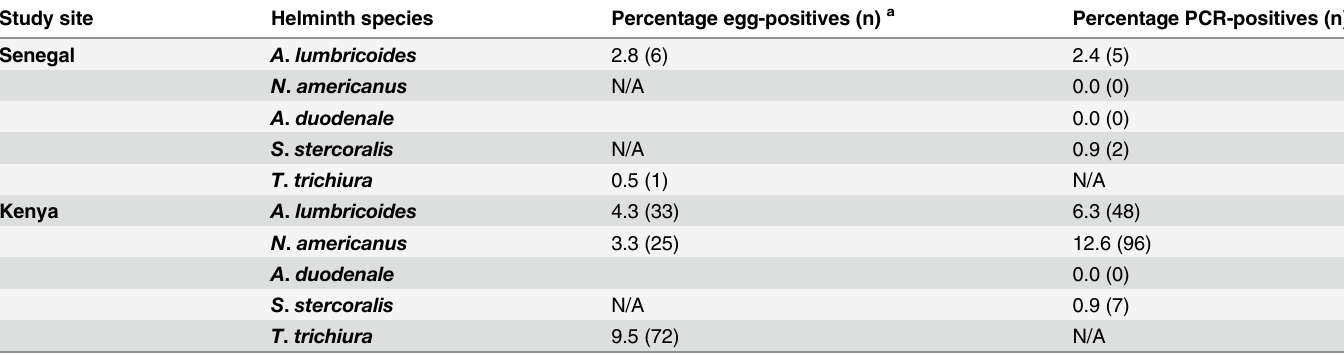
Table 5. Diagnosis of soil-transmitted helminths by Kato-Katz and PCR. a